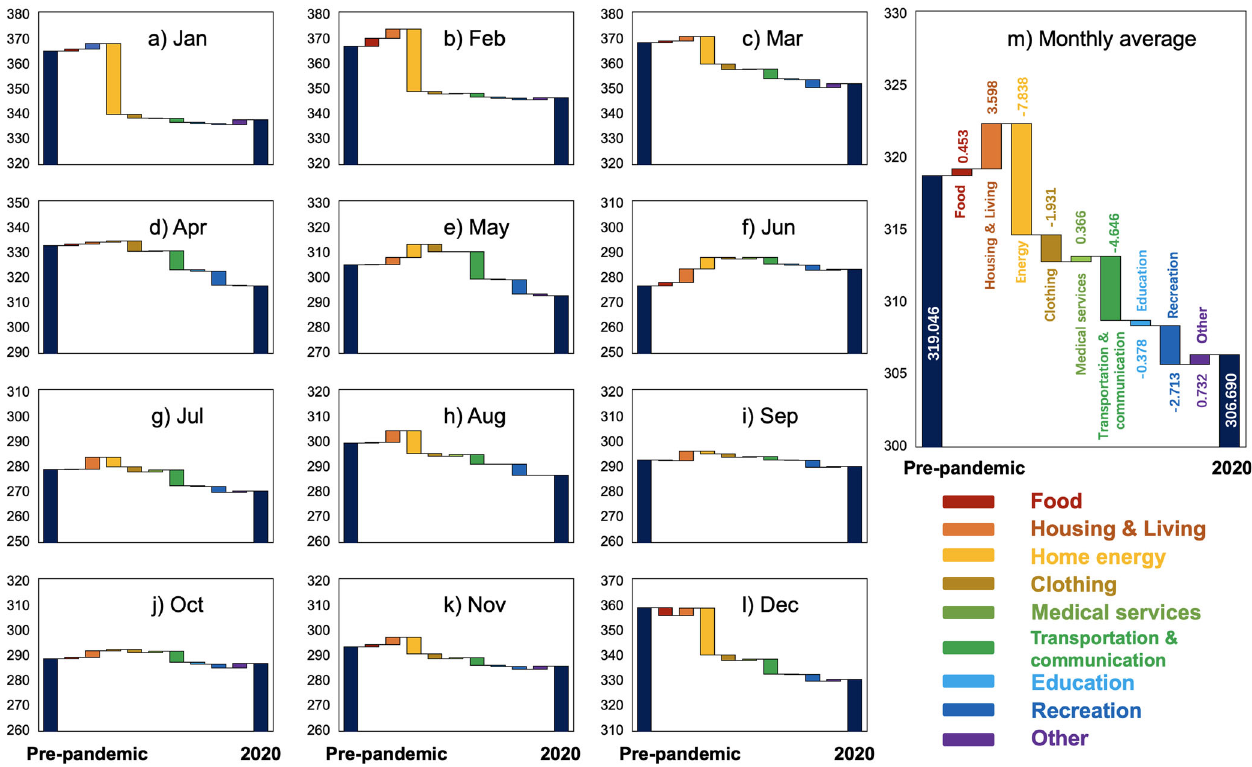
Fig. 5 Total and monthly changes in carbon emissions (in kgCO 2 eq/cap/month) during the COVID-19 pandemic. a − l The results of individual months from January to December, and m The monthly average